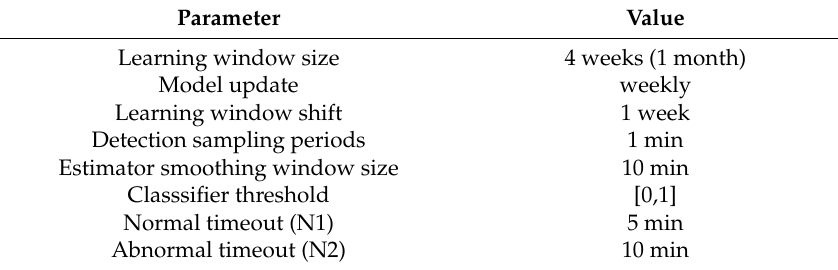
Table 6. Experimental settings.